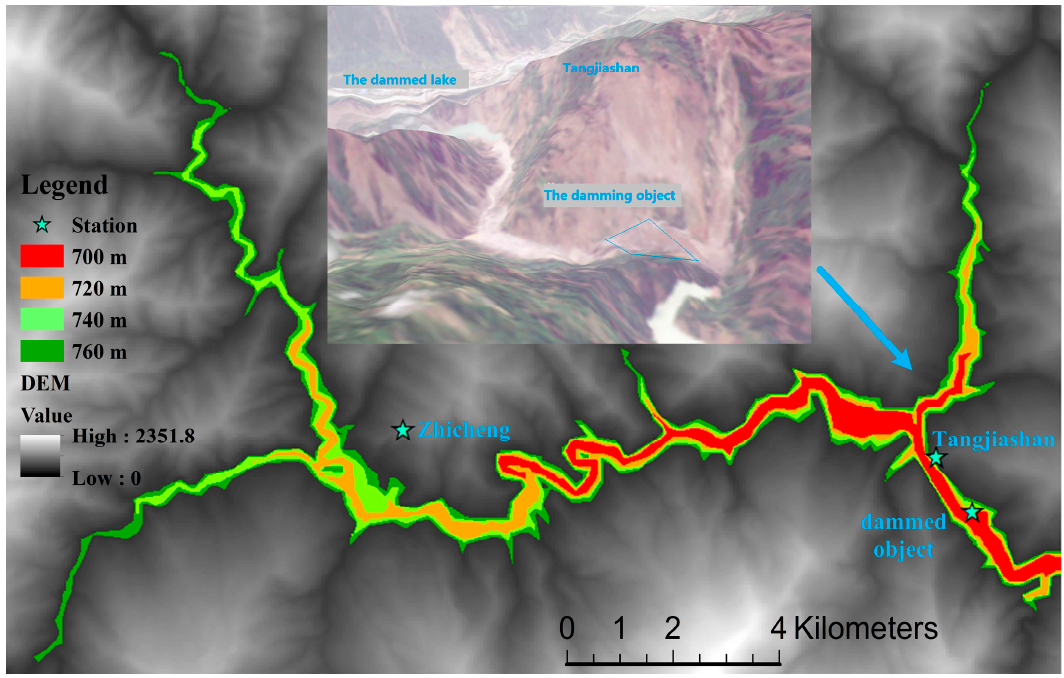
Figure 4. Dammed lake area in different water level.